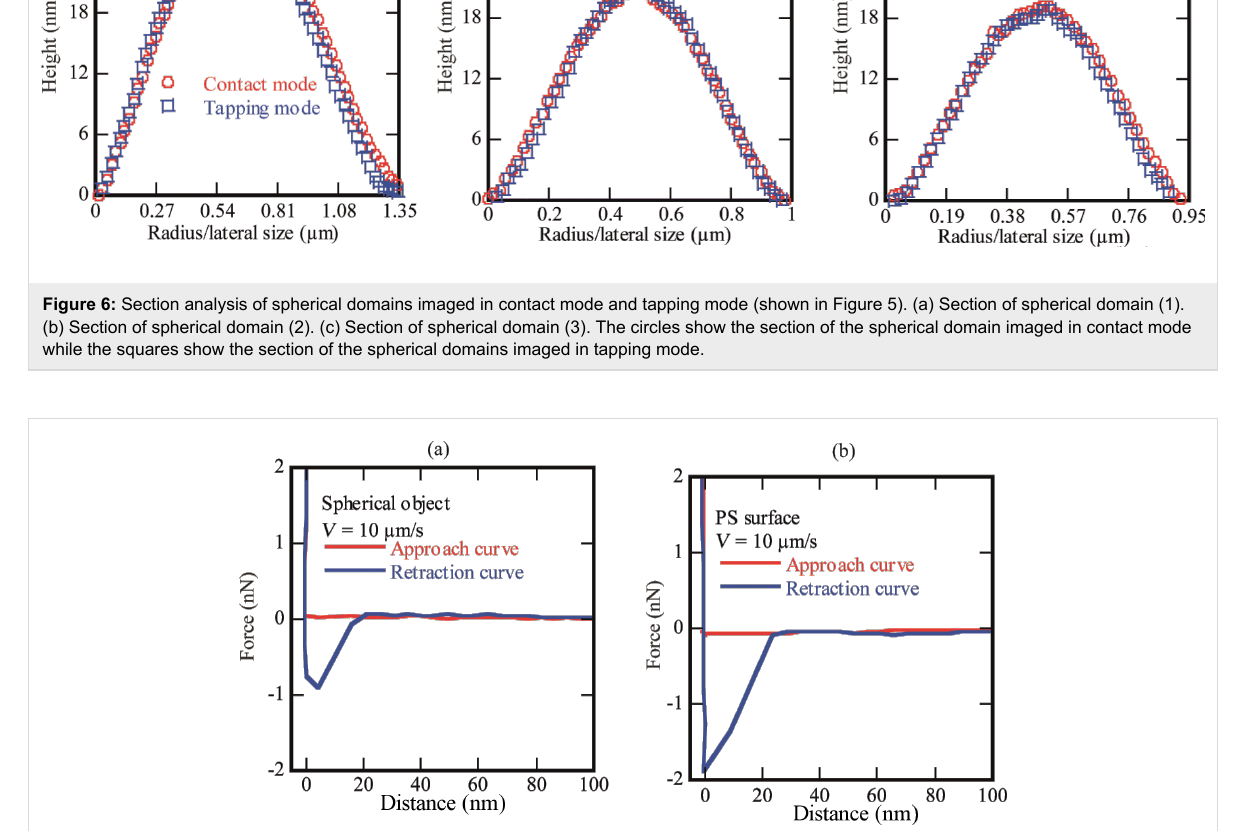
Analysis of the PS film after exposure